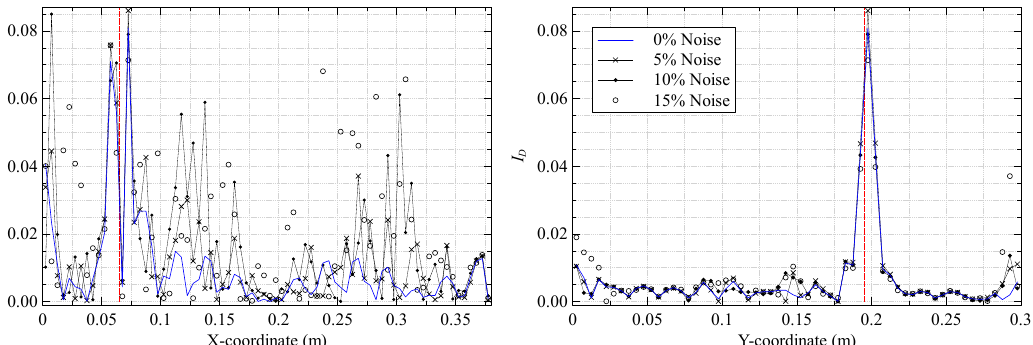
Figure 12. Damage index plots along ( left ) y = 197.5 mm and ( right ) x = 72.5 mm for different noise